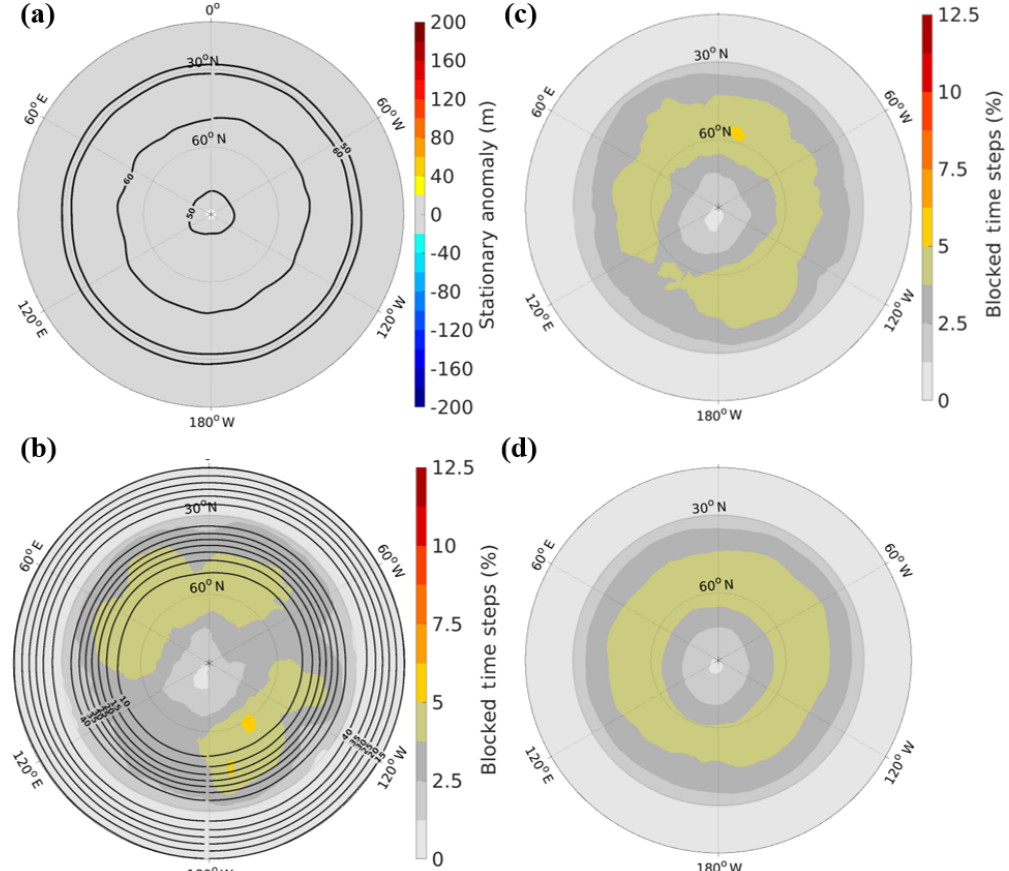
Figure 4. (a, b) For 30 cool seasons (November–March) in the aquaplanet, (a) the stationary wave (shading) and storm track (heavy black contours), and (b) the blocking climatology (shading) and U 250 (heavy black contours) for the idealized model aquaplanet integration. (c, d) Blocking climatology (shading) for (c) 100 and (d) 250 cool seasons in the aquaplanet. In (a) storm track contours are in 10m intervals where the outer contour is 50m. In (b) U 250 contours are in 5ms − 1 intervals where the outer contour is 30ms − 1